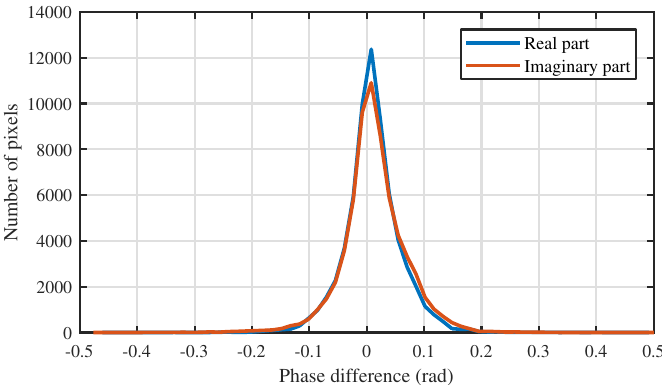
Figure 11. Fitted phase difference histogram curves of Figure